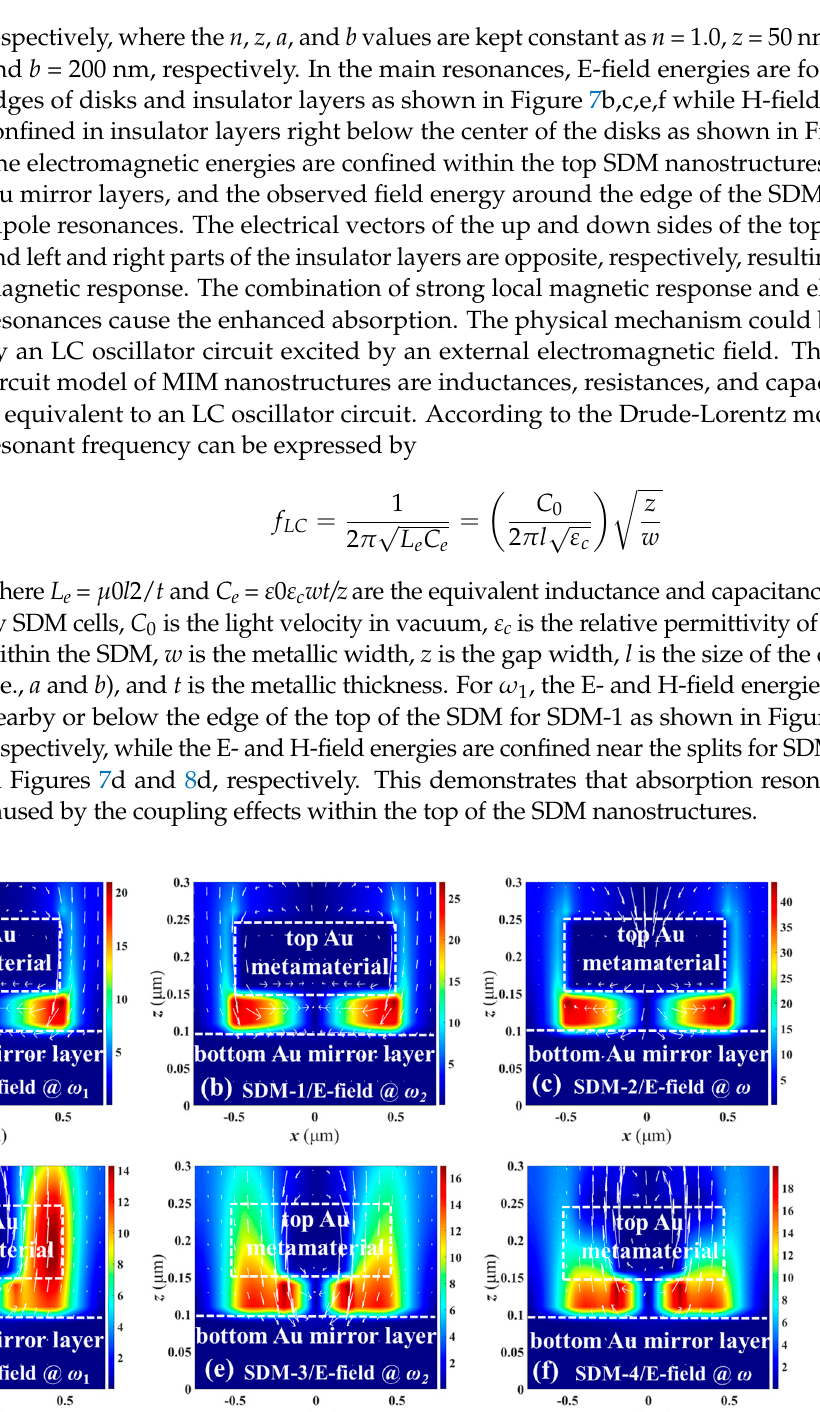
Figure 8. H-field distributions of SDM-1 monitored at ( a ) ω 1 and ( b ) ω 2 resonances, SDM-2 monitored at ( c ) ω resonance, SDM-3 monitored at ( d ) ω 1 and ( e ) ω 2 resonances, and SDM-4 monitored at ( f ) ω resonance, respectively. 4. Conclusions In conclusion: we propose four tunable SDM absorbers. By tailoring the geometrical dimensions, the absorption spectra could be tuned within a “molecule fingerprint” wave- length range, which indicates the potential application as multi-gases sensors and biosen- sors. Furthermore, the absorption intensities decrease by increasing the gap between the SDMs and bottom Au mirror layer. To demonstrate that the proposed SDM devices could be applied as high-sensitive sensors, the SDM devices were exposed to ambient environ- ments with different refraction indexes. The four SDMs exhibit high sensitivity of 3312 nm/RIU, 3362 nm/RIU, 3342 nm/RIU, and 3567 nm/RIU for SDM-1, SDM-2, SDM-3, and SDM-4, respectively. The corresponding FOM are 13.25, 15.28, 20.89, and 17.8 for SDM-1, SDM-2, SDM-3, and SDM-4, respectively. The correlation coefficient is 0.9999. The tuning